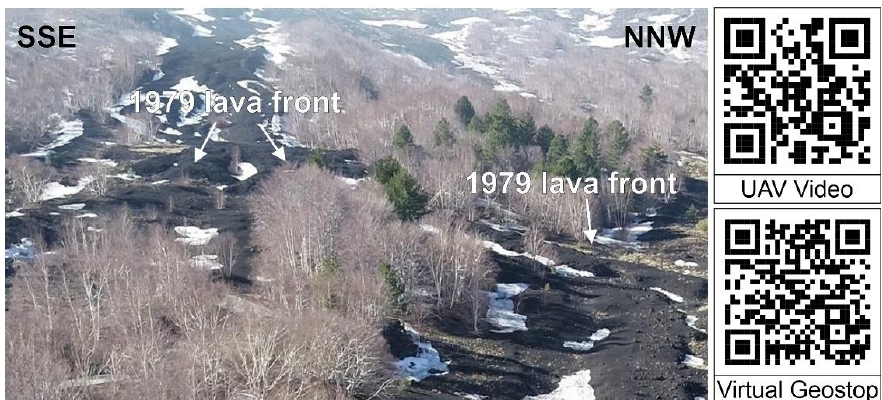
Figure 6. The image on the left shows geostop 4 through an E-looking UAV-captured picture. The QR codes on the right enable opening the corresponding UAV-captured video and the related VG. By using a mobile phone or a tablet, open up the QR code reader. Hold your device over a QR code, so that it is clearly visible on your screen. Press the notification and wait a few seconds.